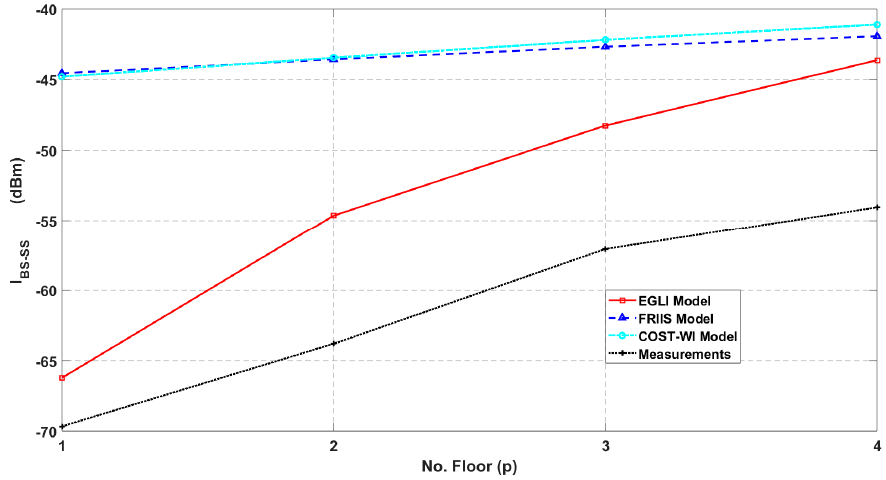
Figure 6. Simulated and measured interference levels received in the apartments located in the front of the small building that presents a line of sight (LOS) with the transmission system.